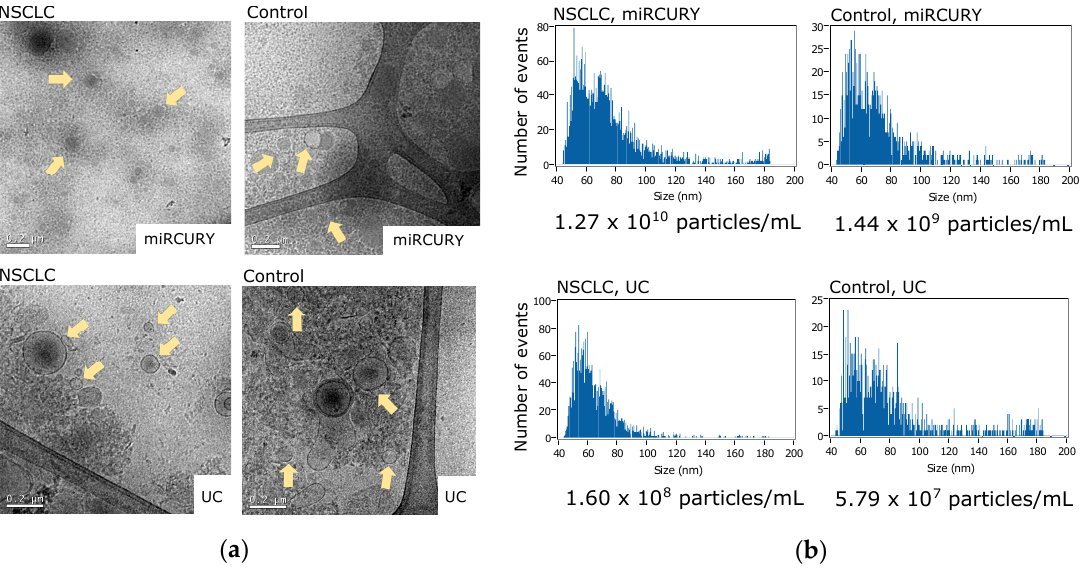
Figure 1. Characterization of extracellular vesicles (EVs) enriched either by differential ultracentrifugation (UC) or precipitation using the miRCURY Exosome Serum/Plasma kit. ( a ) Observation of EV samples on transmission electron microscopy (TEM). Yellow arrows point out EVs of different sizes. Scale bars indicate 200 nm.; ( b ) Nanoflow cytometry (nanoFCM) profiles of EV samples showing size and concentration of 40–200 nm particles.